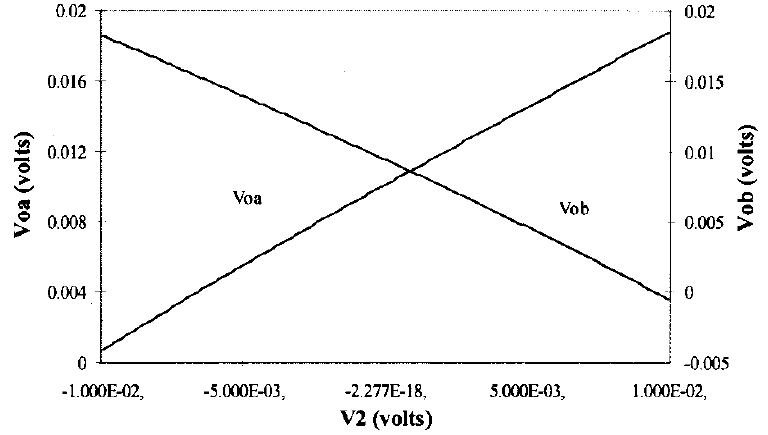
FIGURE 3 DC transfer characteristics for summing (Voa) and difference (Vob) amplifier for V 1 ¼